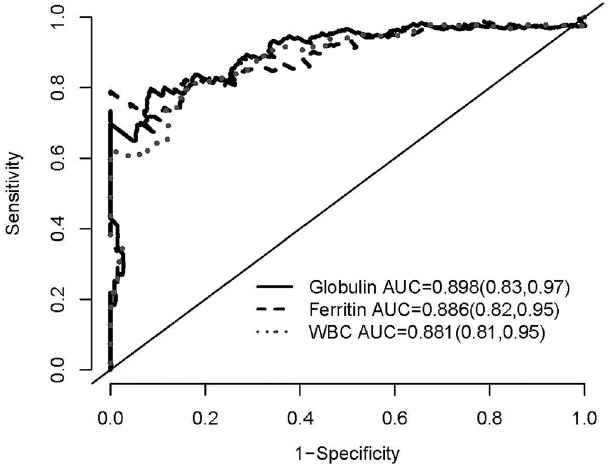
Figure 6. The area under the curve (AUC) by the Receiver Operating Characteristics (ROC) curve analysis of the overall all-cause mortality for variables in model 4 plus globulin, ferritin, and WBC counts, respectively. Numbers in parentheses indicate 95% confidence